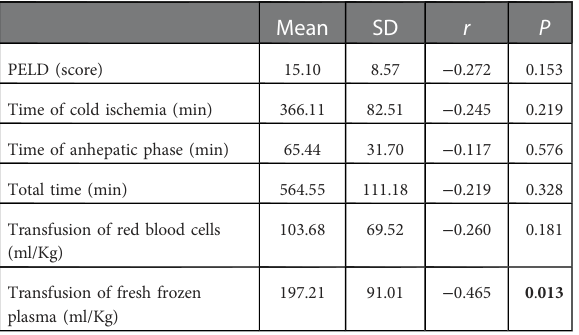
TABLE 4 Correlation of PMI with surgical data.